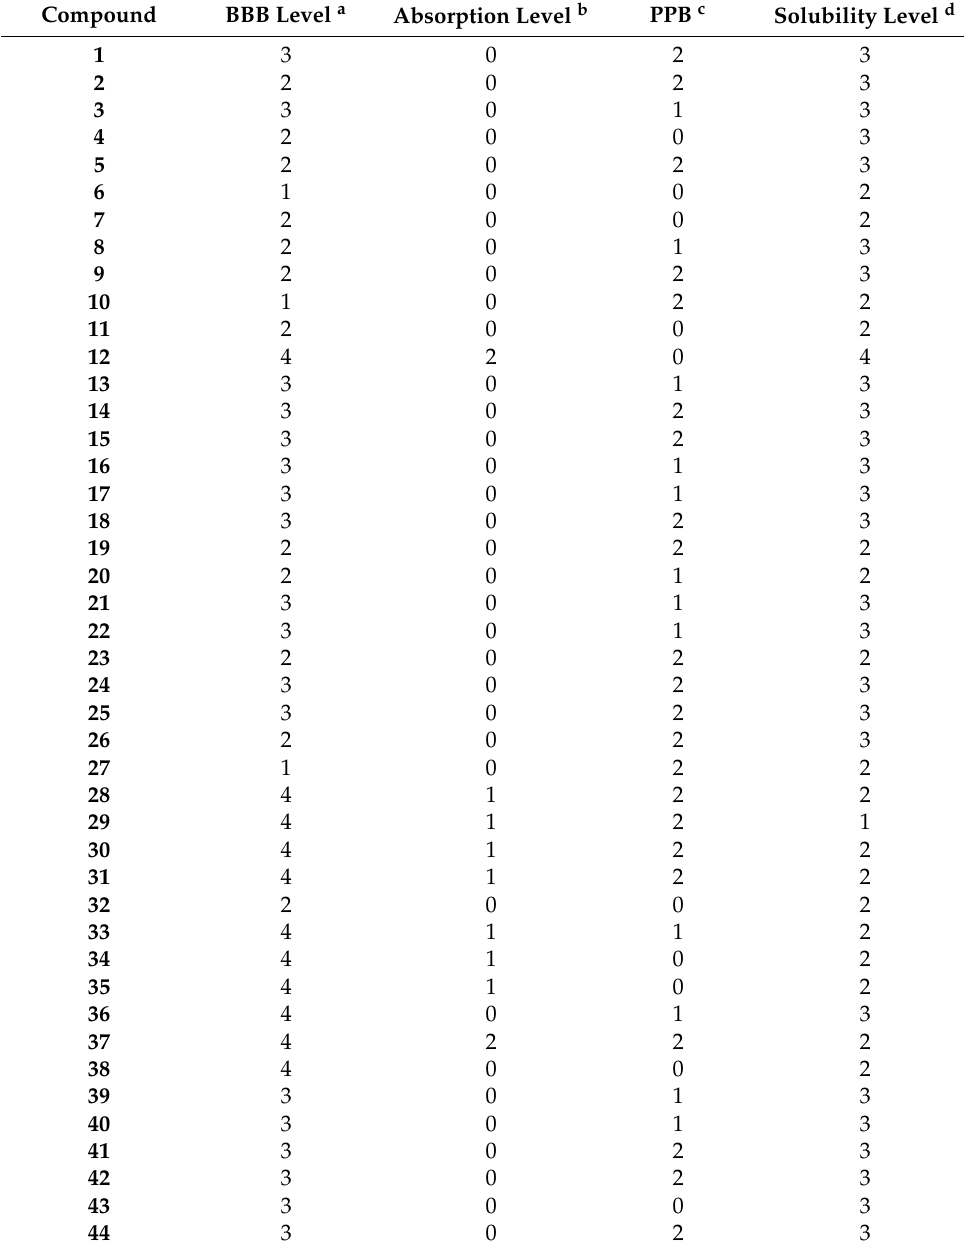
Table 2. Predicted ADMET descriptors for the tested isoflavonoids and